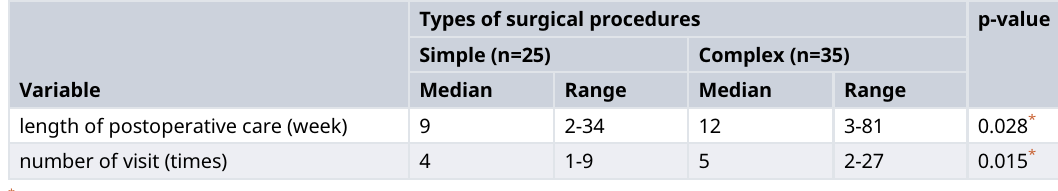
Table 3. Length of care and the number of postoperative visit.